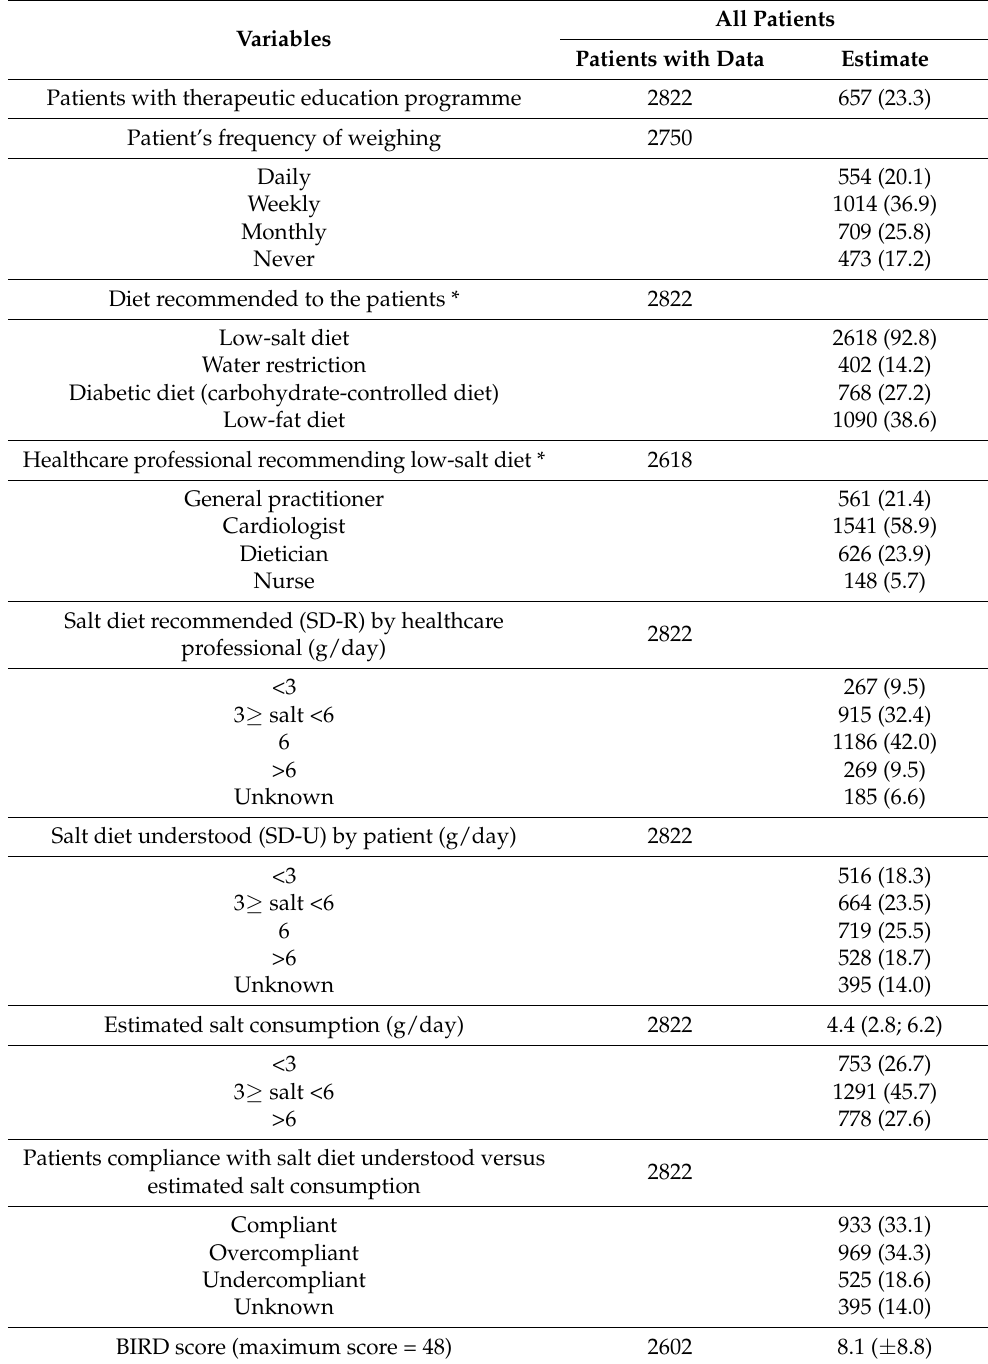
Table 2. Therapeutic education, diet regimens prescribed, and adherence to salt diet in patients enrolled in the OFICSel observatory ( n = 2822). All Patients Variables Patients with Data